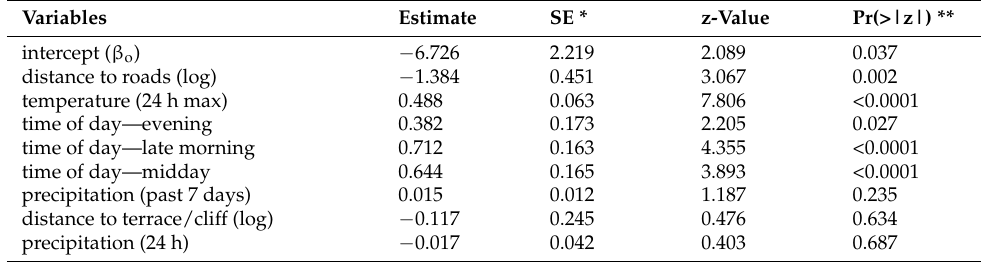
Table 6. Model averaged estimates and significance of the fixed effect variables predicting mouflon visitation rate at the 6 hr time scale, as measured in the number of independent mouflon detection events at ten monitored water troughs (R 2 = 0.562; negative binomial generalized mixed-effect model with site (water trough) and day as nested random effects (fixed slope, random intercept)). Variables Estimate SE * z-Value Pr(>|z|) ** intercept ( β o ) − 6.726